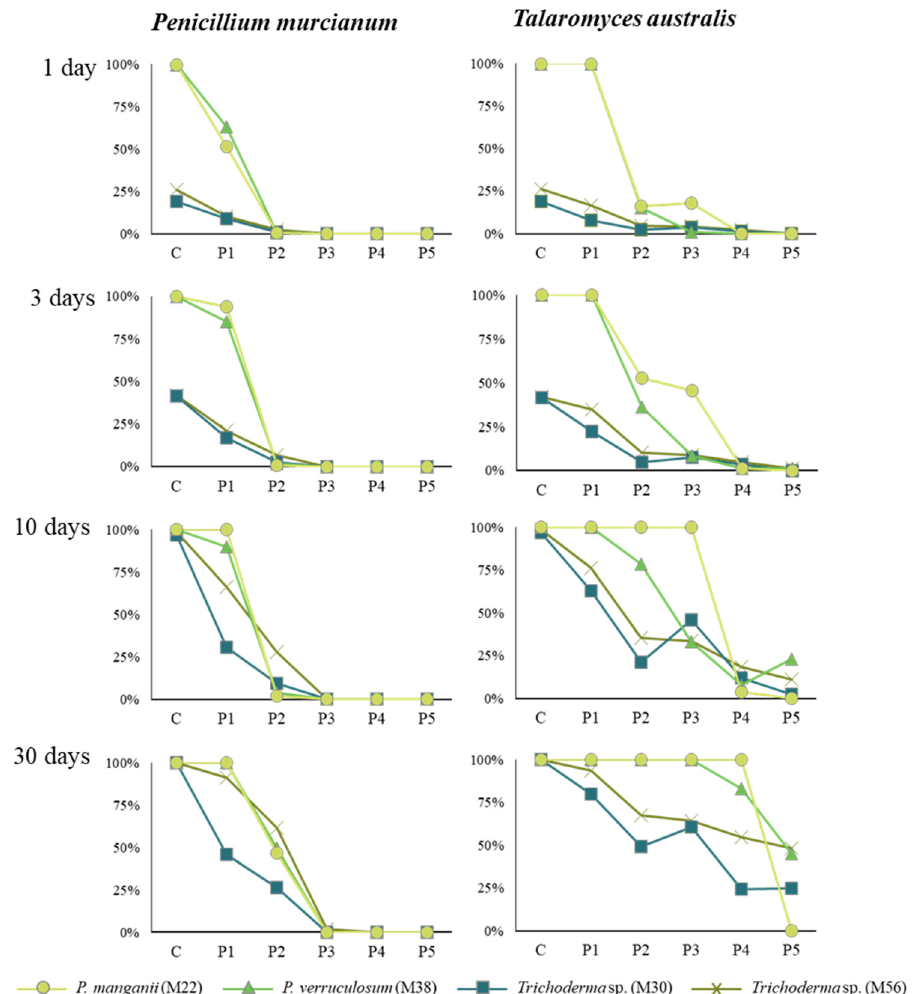
Figure 2. Interaction of colorant concentration of P. murcianum and T. australis , and mean growth area percentage of four mold species after 1 day, 3 days, 10 days, and 30 days of inoculation. The concentrations of colorant were C = Control, P1 = 1 mg/mL, P2 = 2 mg/mL, P3 = 3 mg/mL, P4 = 4 mg/mL, and P5 = 5 mg/mL.